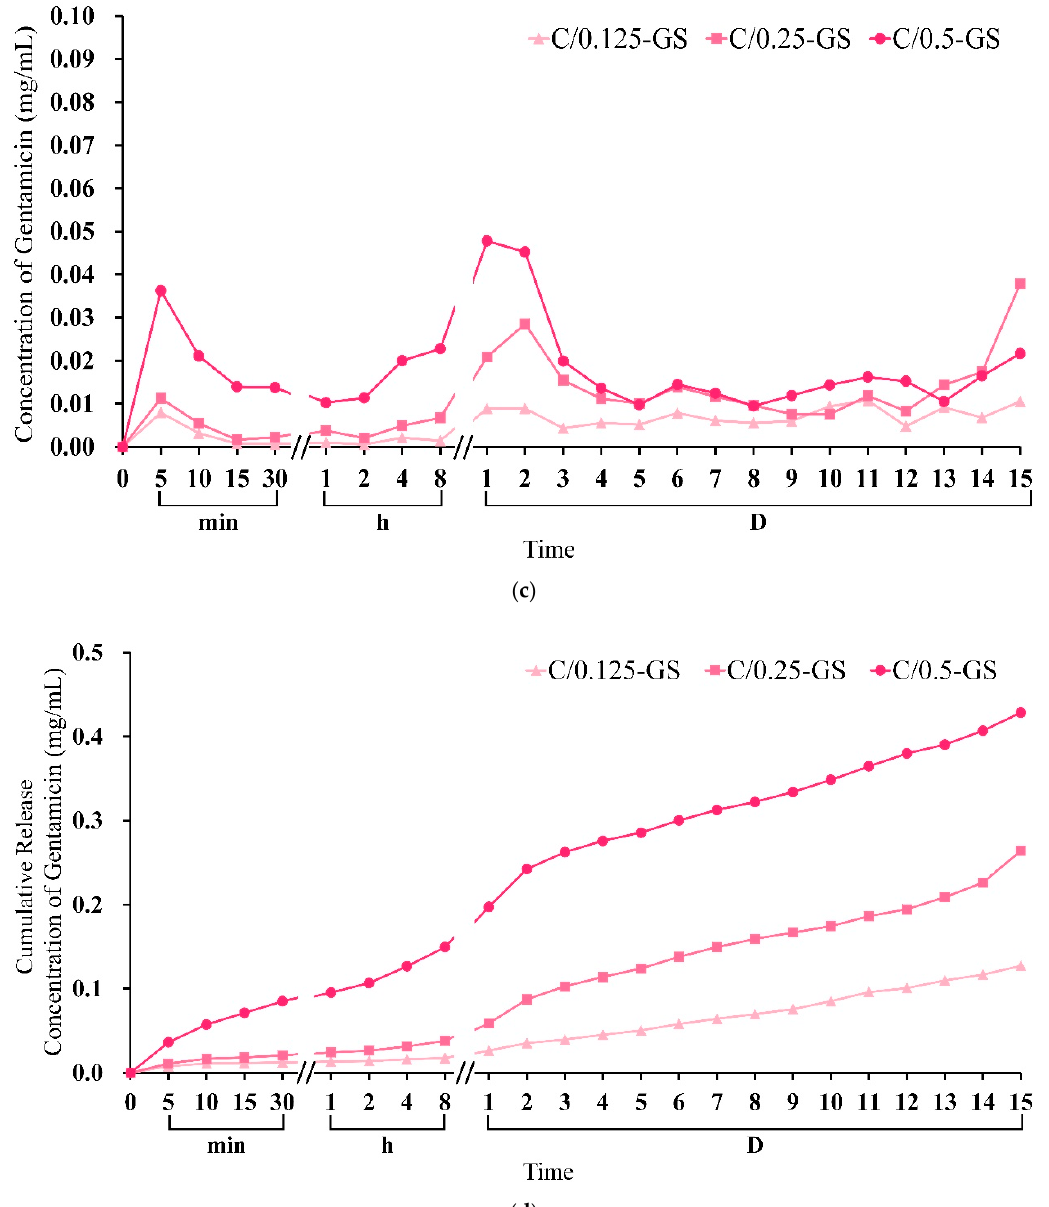
Figure 6. ( a ) Timely release and ( b ) cumulative release of gentamicin from different volumes of hydrogel beads at different time points; ( c ) timely release and ( d ) cumulative release of gentamicin from CPC/hydrogel with gentamicin at different time points ( n = 3).